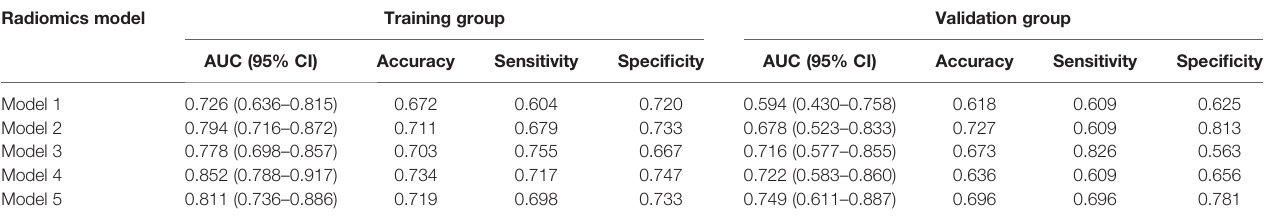
TABLE 2 | The diagnostic performance of radiomics model in the training group and validation